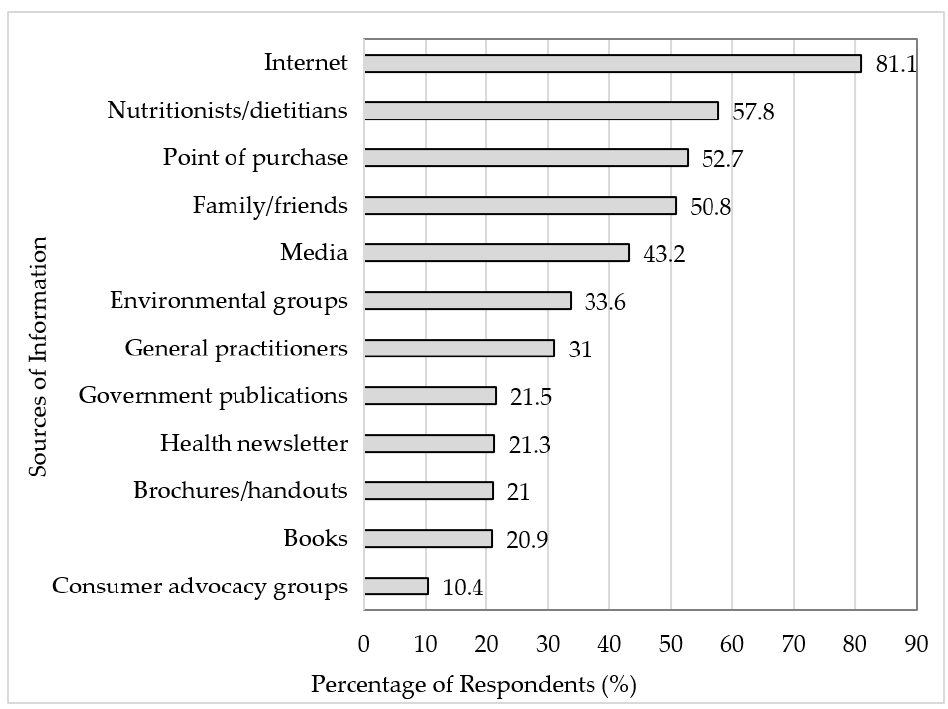
Figure 1. Current sources of seaweed-related information ( n = 1403). The sources are presented in descending order from most to least reported. The data labels are representative of the percentage of respondents.